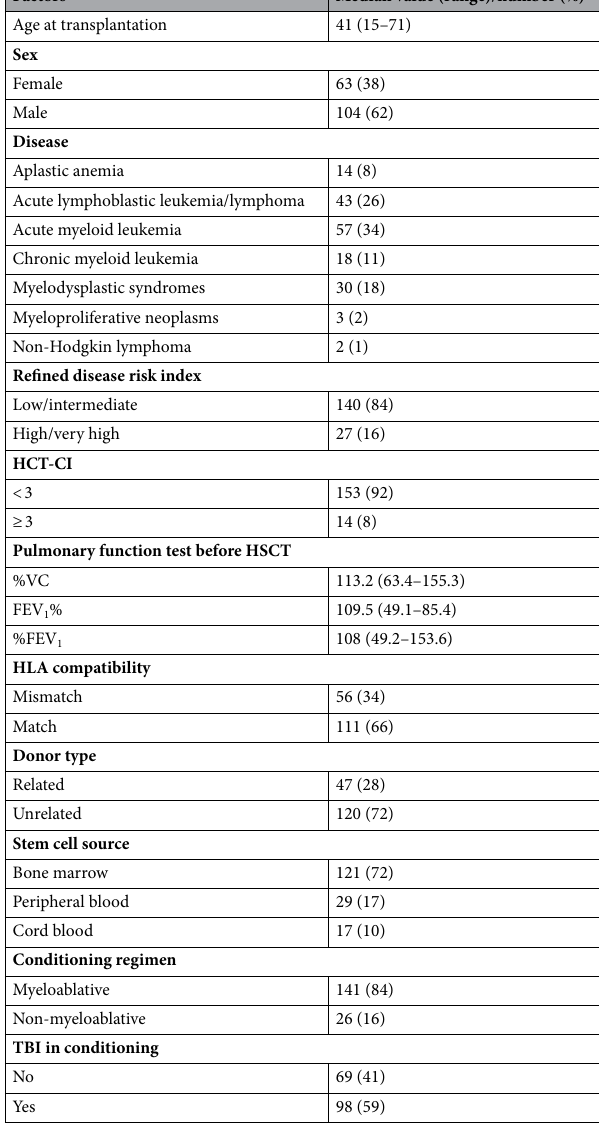
Table 1. Patients characteristics. HCT-CI Hematopoietic Cell Transplantation Comorbidity Index, HSCT hematopoietic stem cell transplantation, VC vital capacity, FEV 1 forced expiratory volume in 1 s, HLA human leukocyte antigen, TBI total body